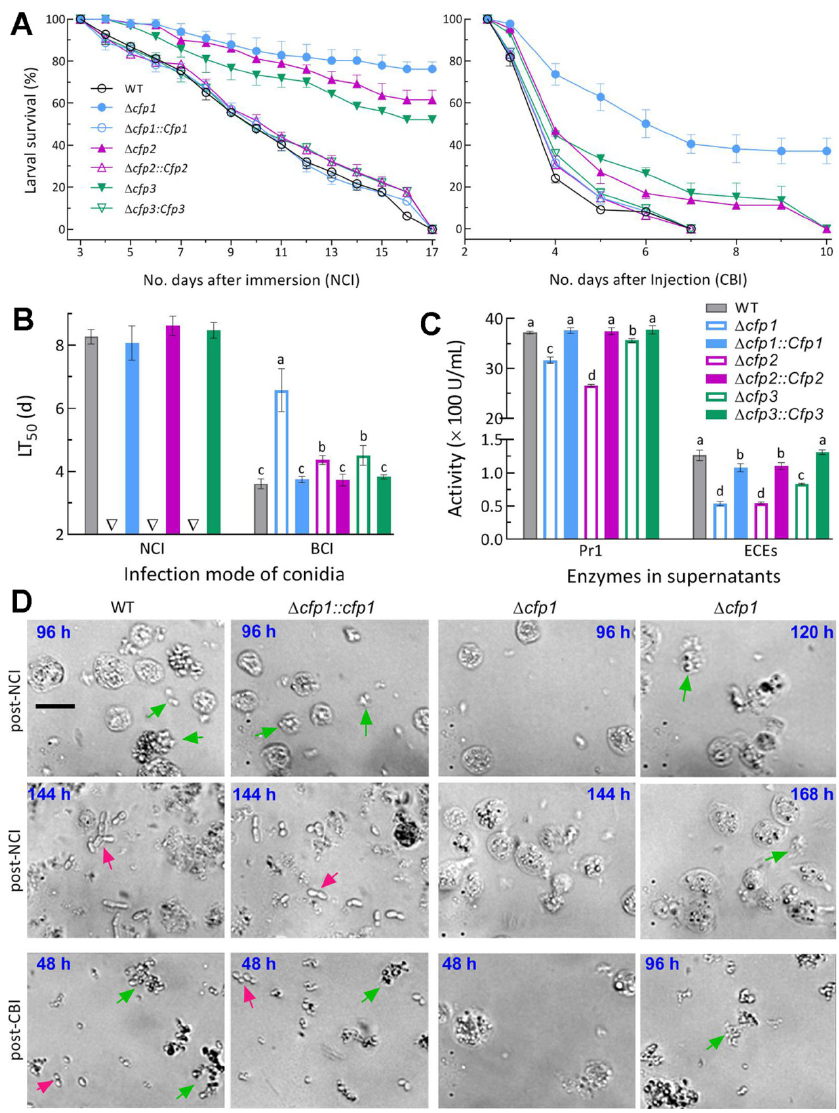
Figure 3. Essential roles of cfp1–3 in the infection cycle of M. robertsii . ( A ) Survival trends of G. mellonella larvae after normal cuticle infection (NCI) via immersion in a 2 × 10 7 conidia/mL suspension and cuticle-bypassing infection (CBI) via intrahemocoel injection of ~250 conidia per larva. ( B ) LT 50 values estimated from time-mortality trends. Triangles indicate unavailable LT 50 s for three deletion mutants via NCI. ( C ) Total activities of extracellular enzymes (ECEs) and Pr1 proteases quantified from the supernatants of 3 d-old submerged cultures, which were generated by shaking incubation of a 10 6 conidia/mL suspension in CDB-BSA. ( D ) Microscopic images (scale bar: 20 µ m) for status and abundance of fungal cells (arrowed) and insect hemocytes (spherical or subspherical cells) in hemolymph samples, which were taken from surviving larvae at different time points after NCI (upper) and CBI (lower) and incubated at 25 ◦ C for 36 h in SDBY. Green arrows indicate fungal cells released from aggregated hemocytes. Red arrows indicate yeast-like budding proliferation of fungal cells released. Different lowercase letters in ( B , C ) indicate significant differences (Tukey’s HSD, p < 0.05). Error bars: SDs from three independent